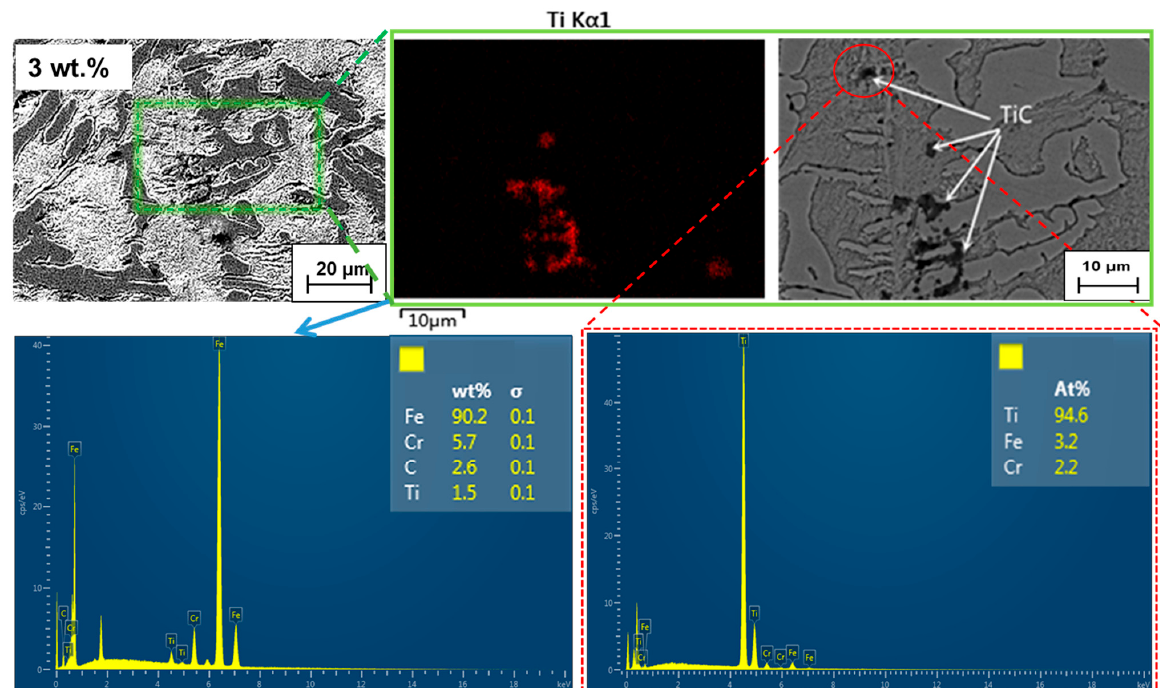
Figure 7. Representative backscatter images and EDS patterns of TiC in the samples under 3.0 wt.% Ti 3 AlC 2 . Schematic illustrations of TiC enrichment at the solid–liquid front.